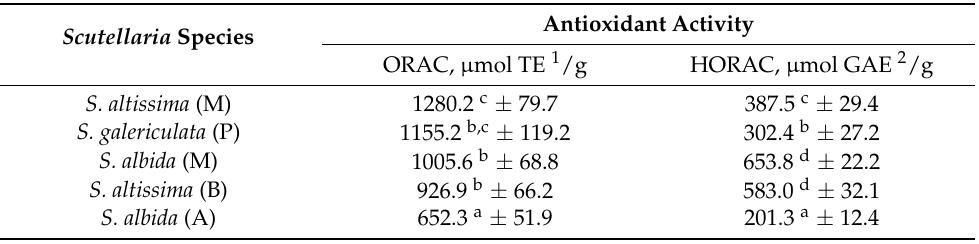
Table 4. Oxygen Radical Absorption Capacity (ORAC) and Hydroxyl Radical Averting Capacity (HORAC) Antioxidant Activity of Extracts from Scutellaria Species.